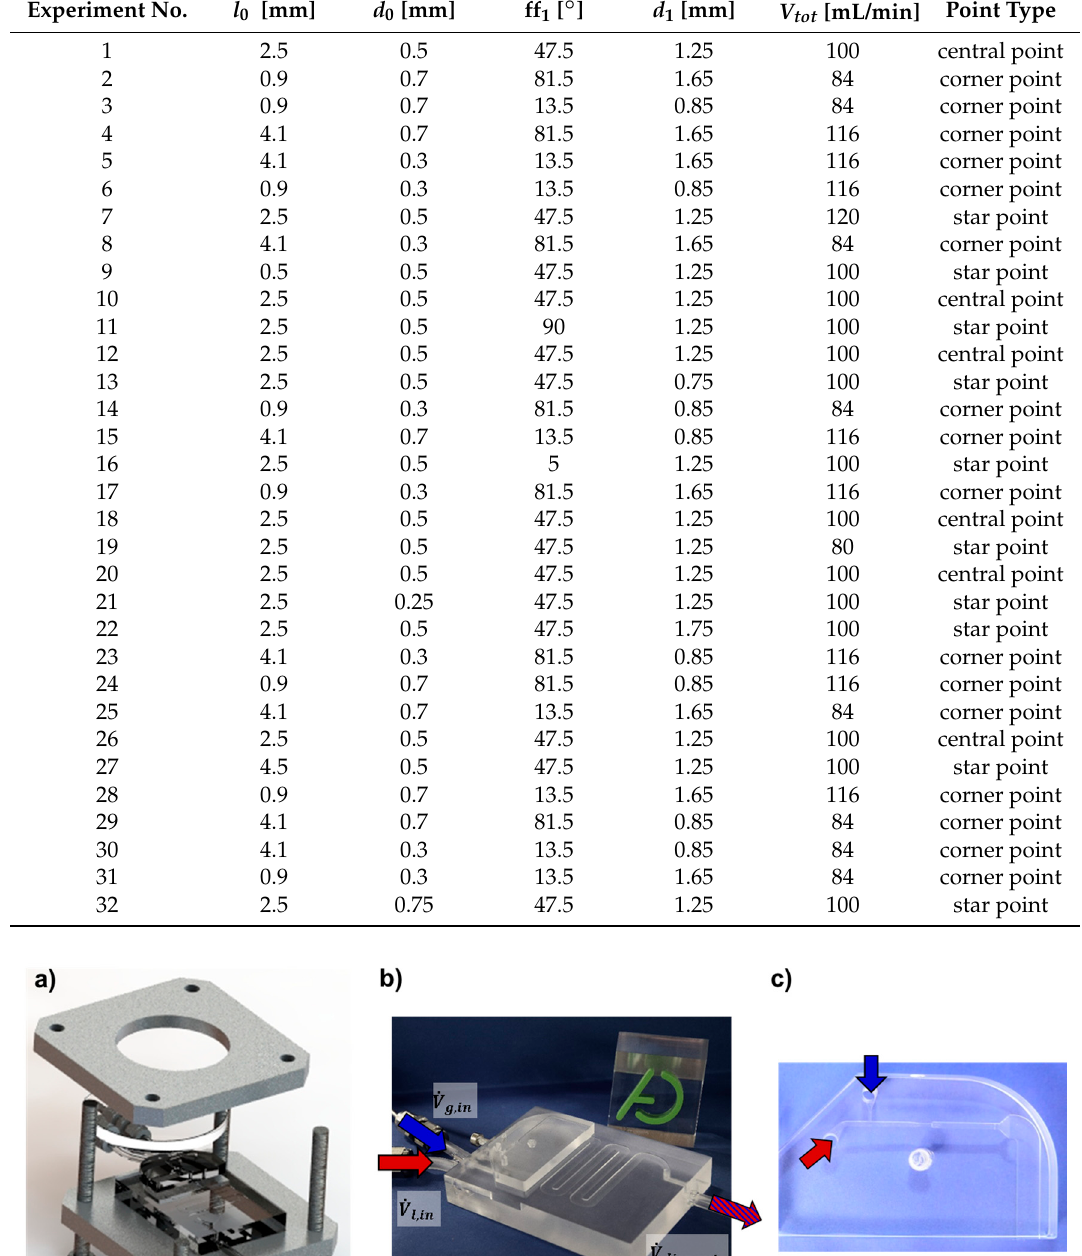
Table 3. Generated DoE using statistical software Minitab ® 17 for the investigation of energy optimized turbulent bubble breakup. Experiment No.